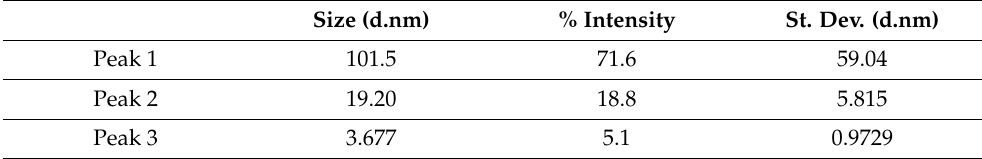
Table 1. Specifications of peaks observed in DLS.